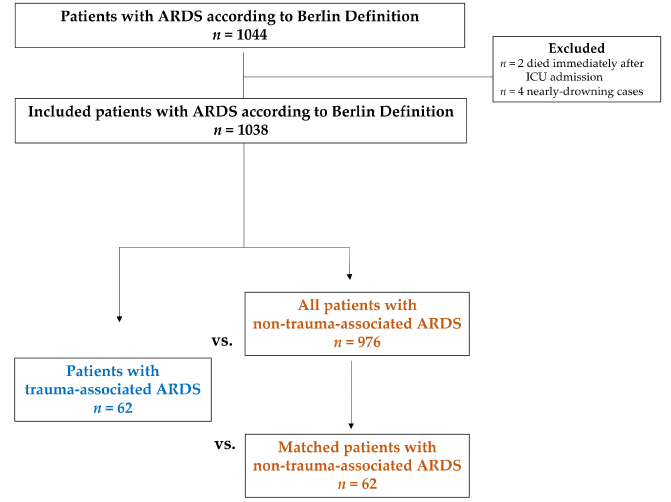
Figure 1. Flow chart of the study cohort and